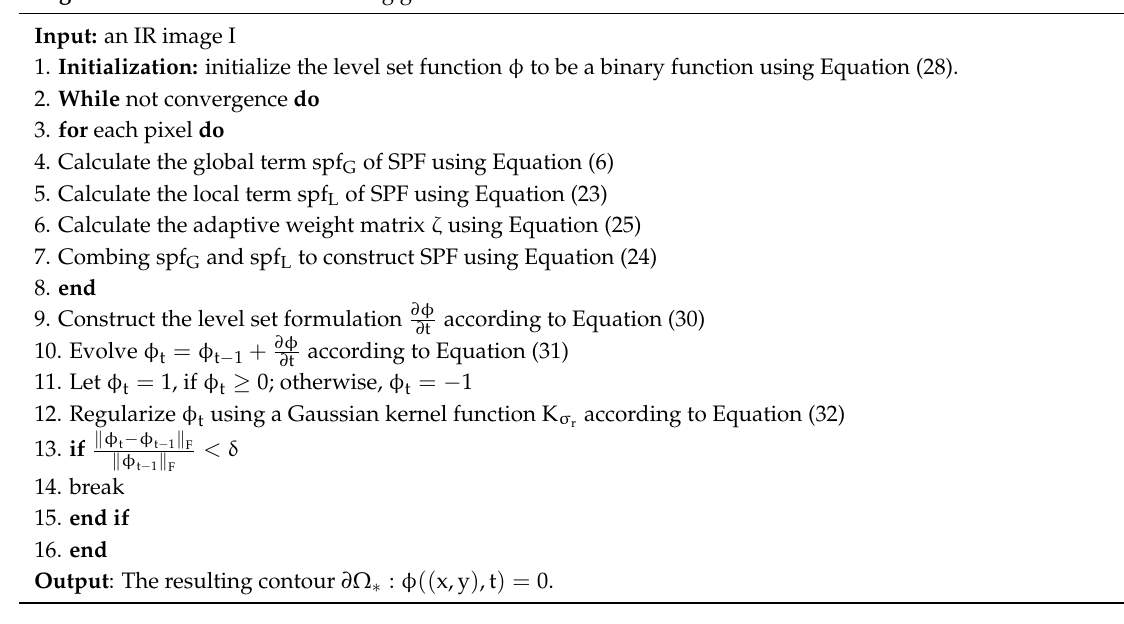
Algorithm 1 Level set method using global and local